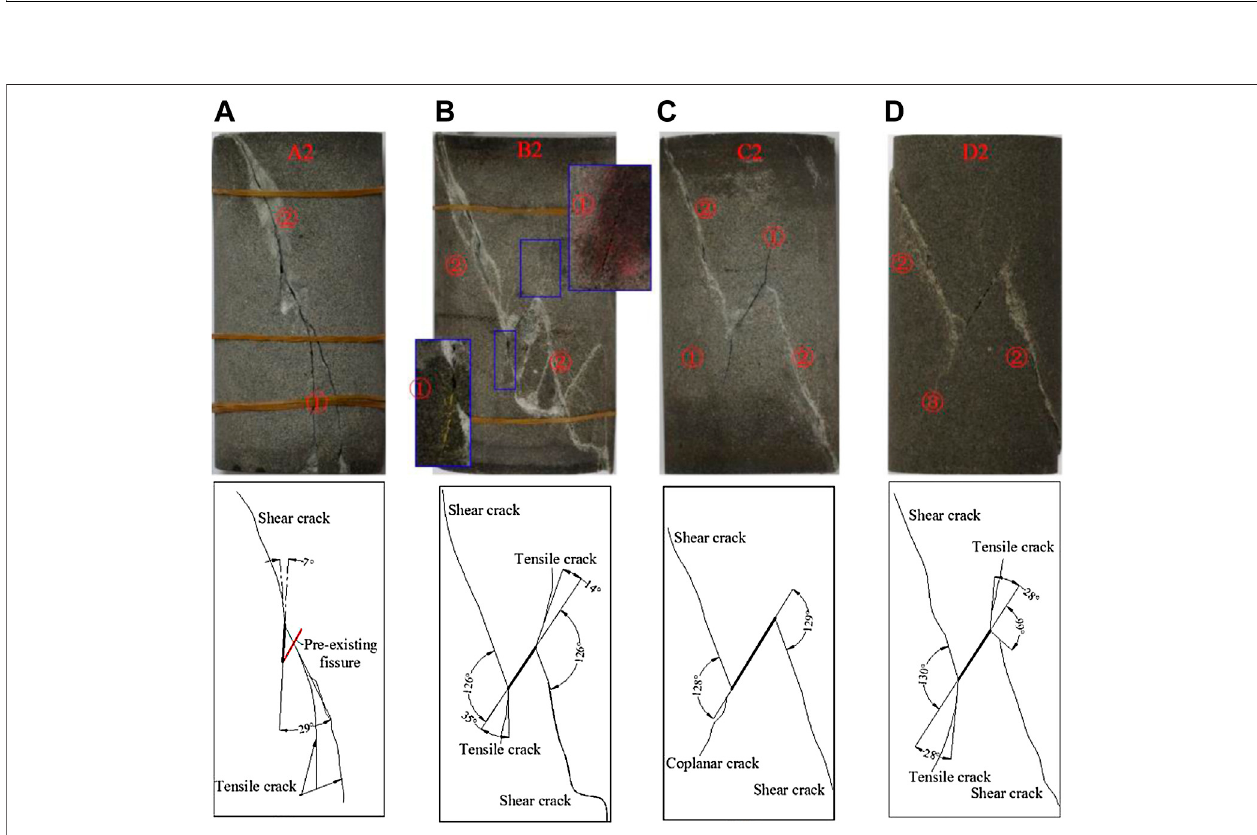
FIGURE 5 | Failure modes of sandstone samples with a fi xed crack angle of 60 ° and single crack lengths of (A) A2, 60 ° , 10 mm, (B) B2, 60 ° , 15 mm, (C) C2, 60 ° , 20 mm, and (D) D2, 60 ° , 25 mm.